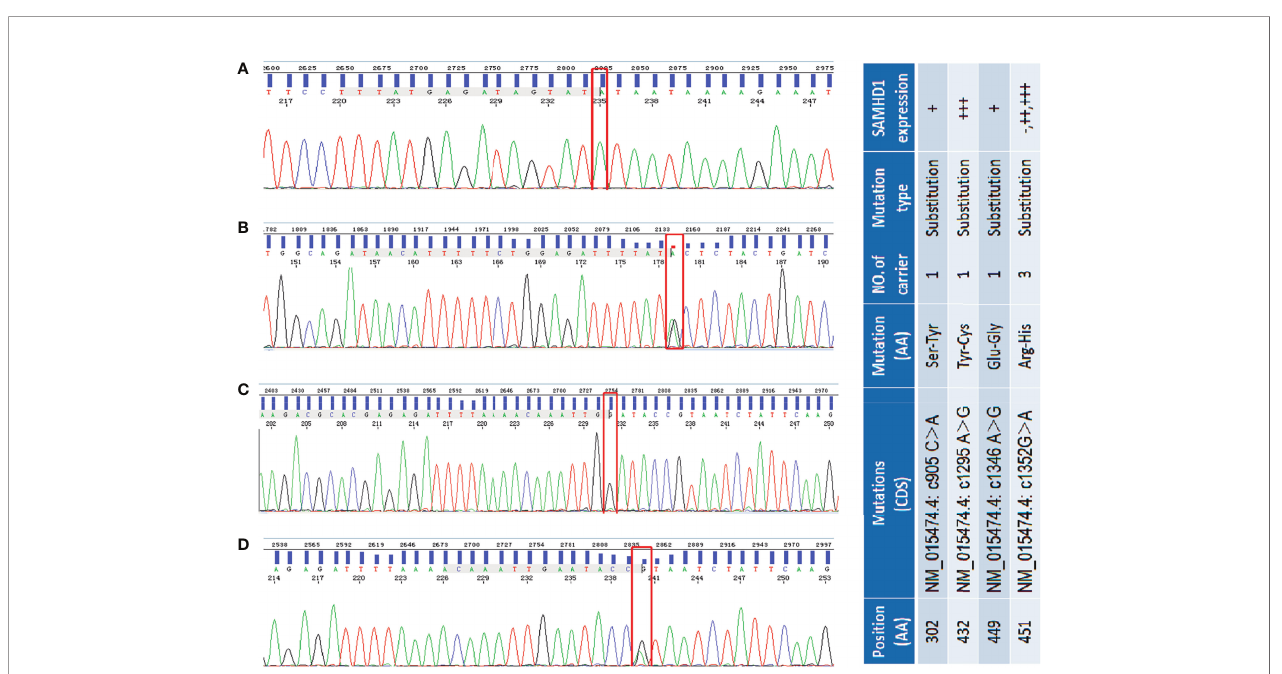
FIGURE 2 | Selected sequencing chromatograms of SAMHD1 using Sanger sequencing. Panel (A) shows the homogeneous c905 C>A mutation (red box highlighted) in exon 8 of SAMHD1 . Panel (B) shows the heterogeneous c1295A>G transition in exon 12 of SAMHD1 . In panel (C) , the highlighted red box represents the homogeneous c1346G>A transition in exon 12 of SAMHD1 . Panel (D) is the heterogeneous c1552G>A mutation in exon 12 of SAMHD1. The included table on the right is the correlation of SAM HD1 mutations and their expression in MCL